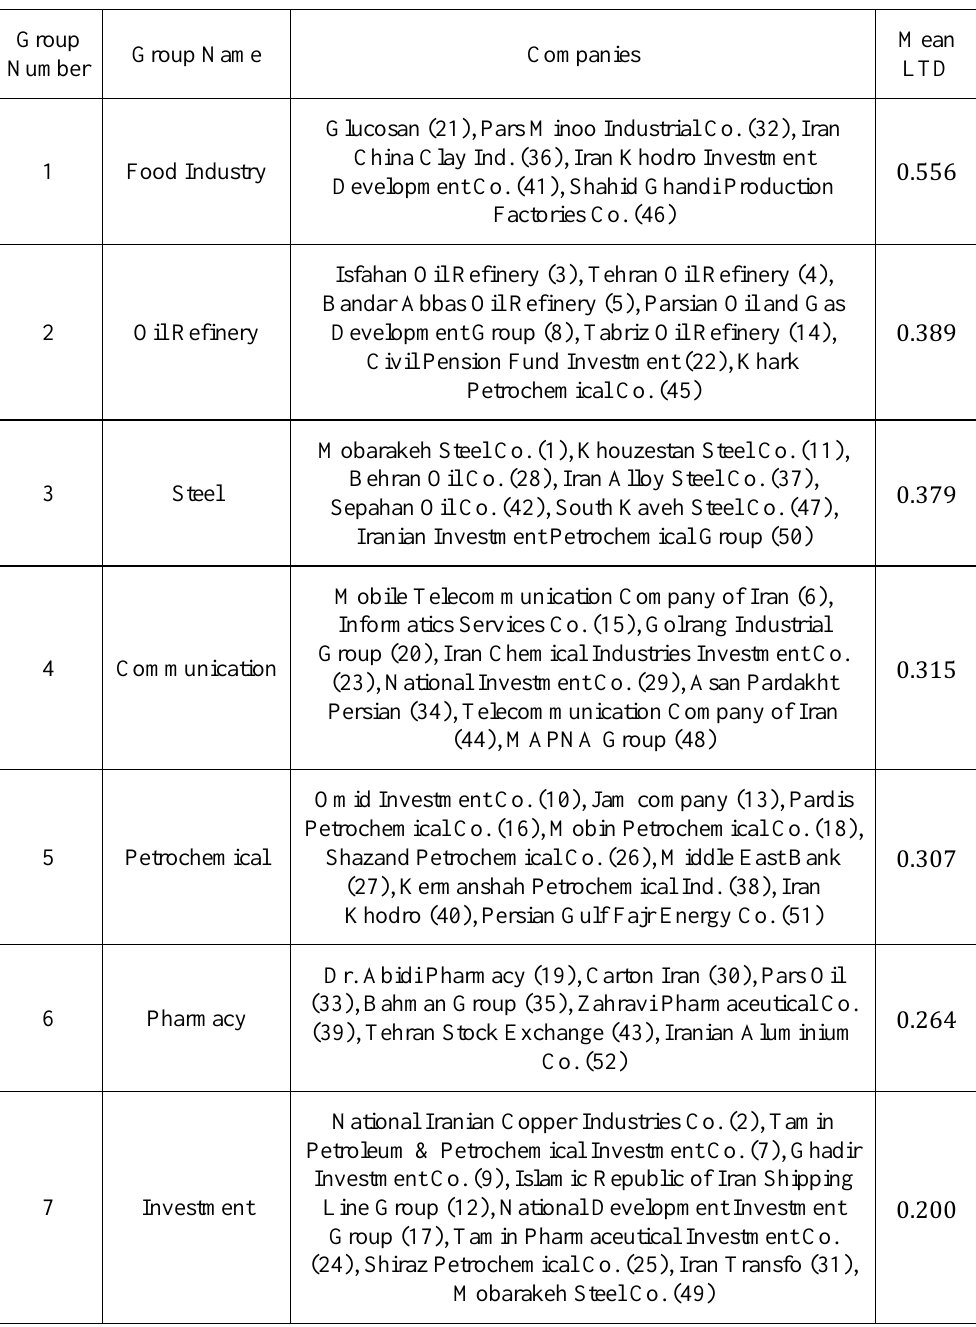
Table 2. Dividing companies into different groups on